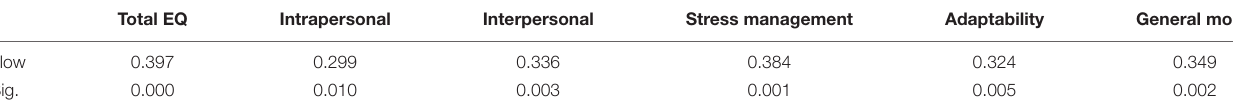
TABLE 2 | Correlations between the teachers’ flow state and five main EQ-i subscales. Total EQ Intrapersonal Interpersonal Stress management Adaptability General mood